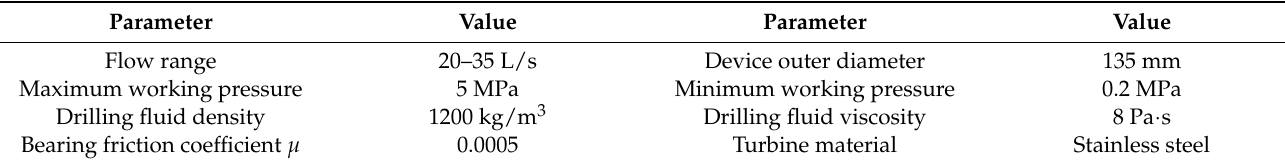
Table 2. Process parameters of simulation